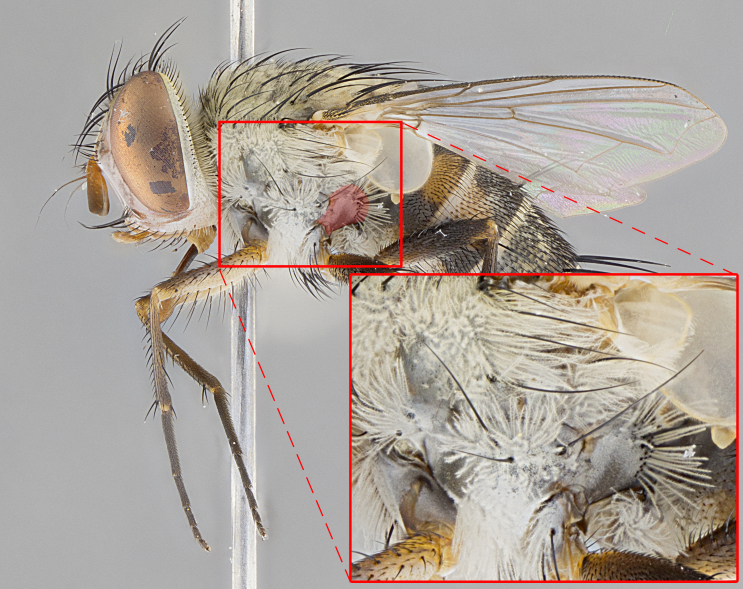
lateral habitus of Telothyria
relicta female (voucher n. DHJPAR0050630) inset detailing the presence of plumose meral setae.